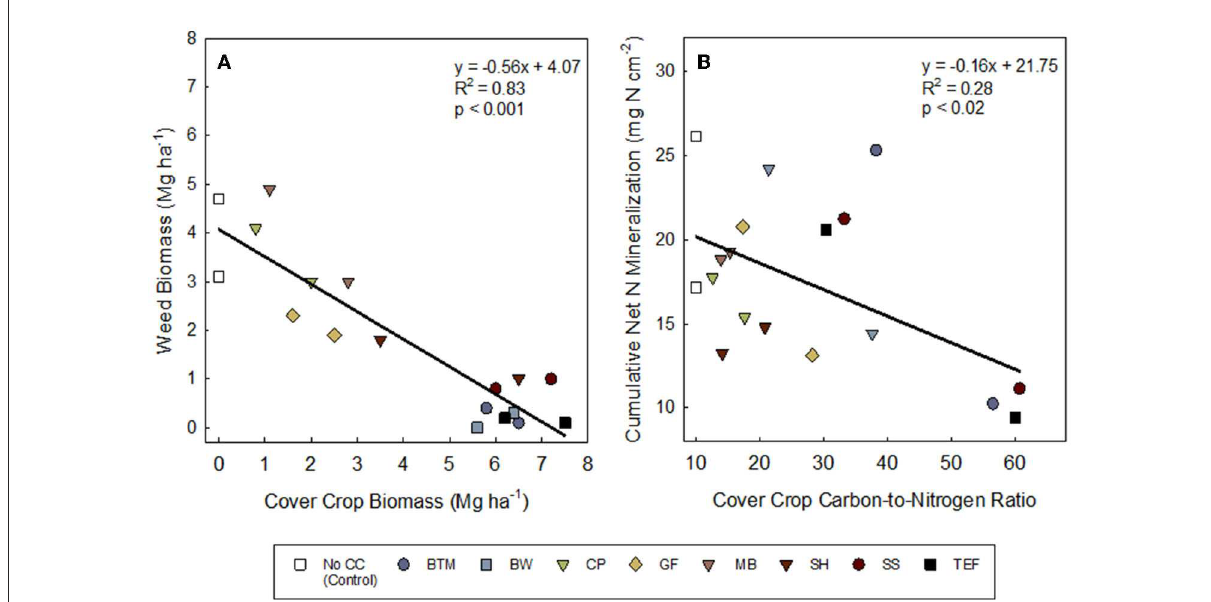
FIGURE2 Relationships between (A) cover crop and weed biomass (Mg ha − 1 ) and (B) cover crop tissue carbon-to-nitrogen ratio and potential cumulative net nitrogen mineralization measured with ion exchange mebranes. Both 2019 and 2020 data are included in the figure. Treatments: NCC, no cover crop (Control); BTM, brown top millet; BW, buckwheat; CP, cowpea; GF, golden flax; MB, mung bean; SH, sunnhemp; SS, sorghum sudangrass; TEF, teff. Leguminous cover crops are shown in downward triangle ( ∇